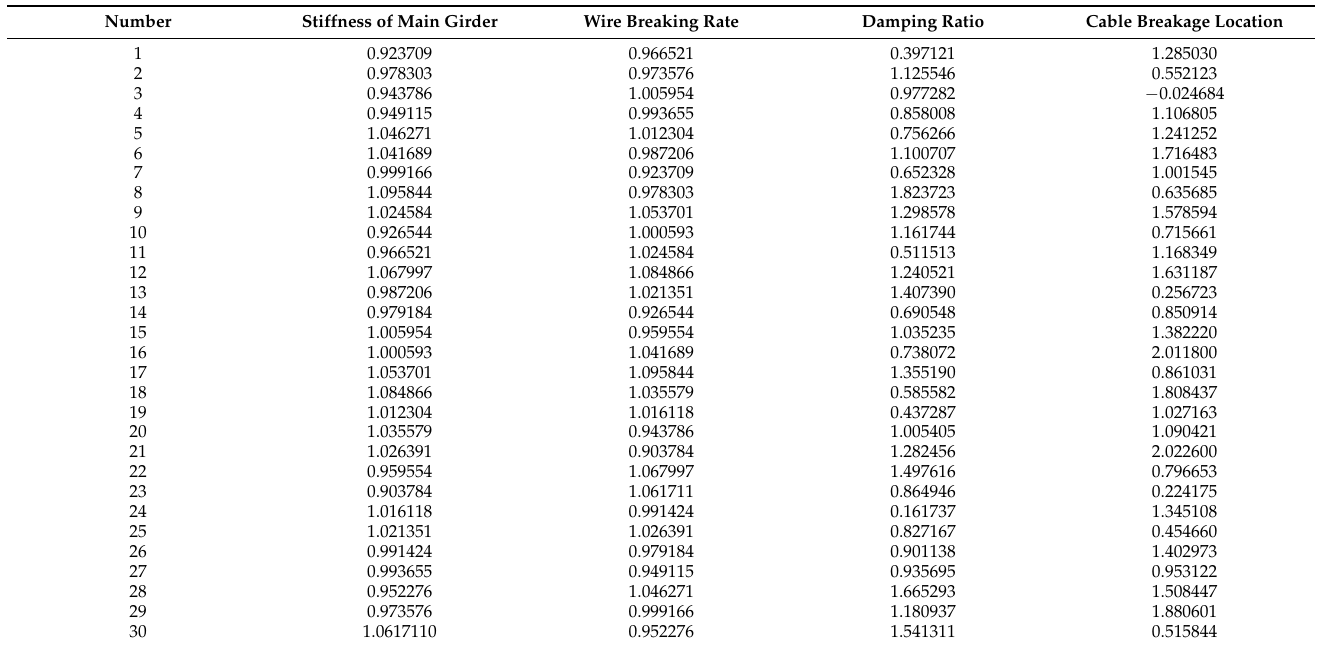
Table 7. Results of Latin hypercube sampling performed 30 times with different